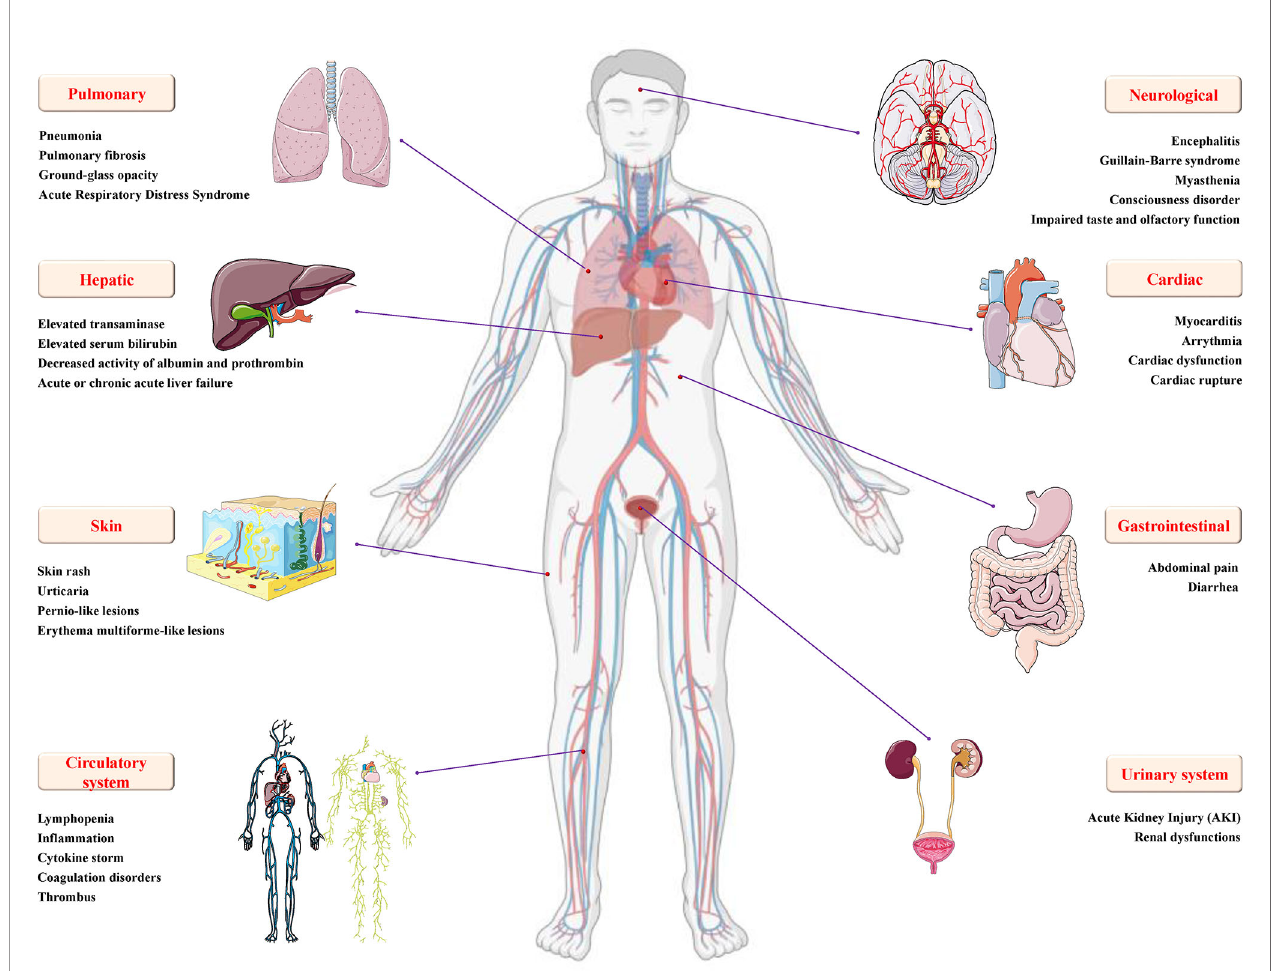
FIGURE 3 | Details of multiple organ injury caused by SARS-CoV-2. In addition to varying degrees of pulmonary in fl ammation, embolism, and acute respiratory distress syndrome, COVID-19 caused by SARS-CoV-2 infection can also cause various organ dysfunctions and damages, including but not limited to encephalitis, Gillan-Barre syndrome, muscle weakness and other nervous system dysfunction; increased blood pressure, arrhythmia, myocardial ischemia, cardiac insuf fi ciency, rupture and other cardio/cerebrovascular system damage; urogenital system damage, such as glomerular congestion and acute kidney injury; digestive system damage, such as diarrhea, increased transaminase/serum bilirubin, decreased albumin/prothrombin activity, acute or chronic acute liver failure, and skin and circulatory diseases, such as skin rash, urticaria, pernio-like lesions, in fl ammation, cytokine storm, coagulopathy and